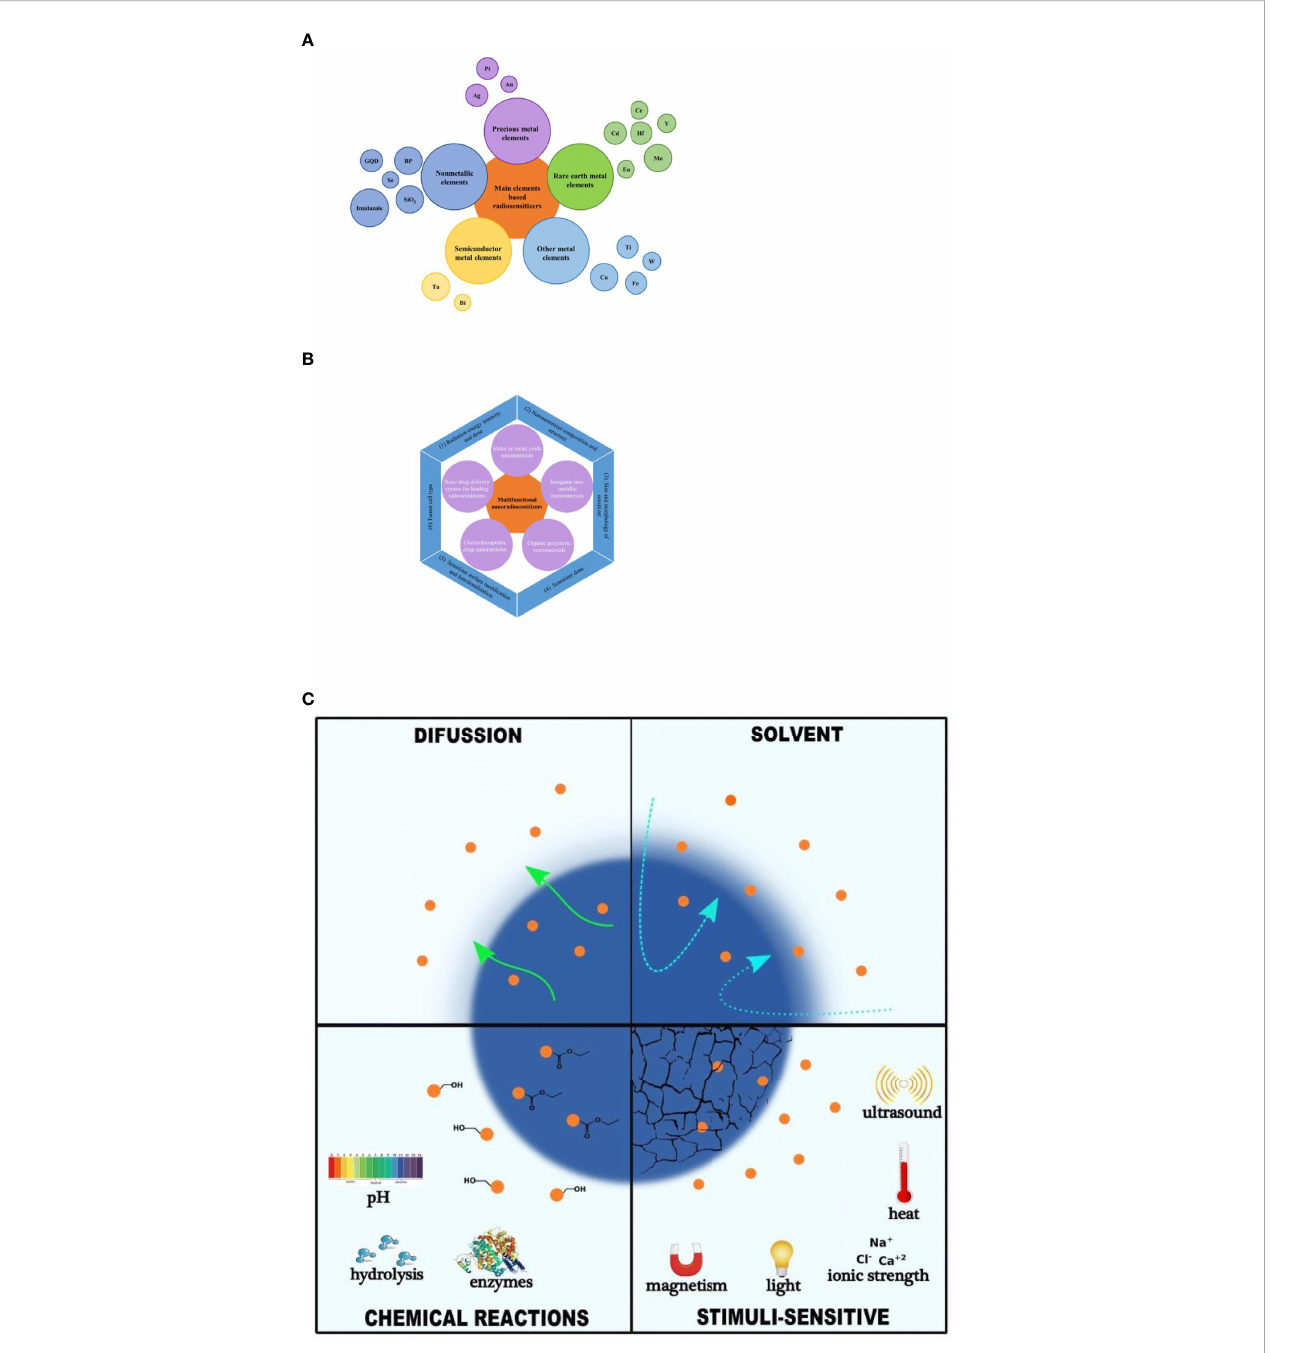
FIGURE 1 Classi fi cation related to nanoradiotherapy sensitization. (A) Classi fi cation of main element-based nanomaterials as radiosensitizers. (B) Main types and in fl uencing factors of nano-radiosensitizers. (C) Mechanisms of controlled drug release using different types of nanocarriers. This research was originally published in (9). Copyright(2018) Recent Patents on Drug Delivery &